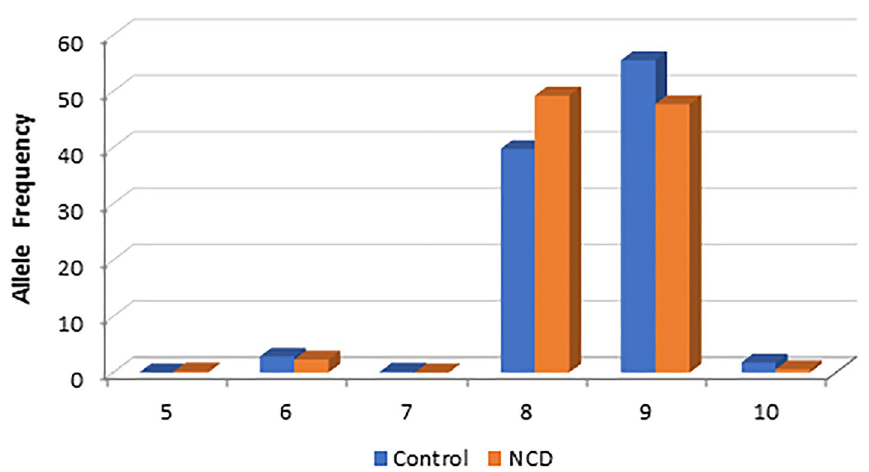
Figure 1. Allele frequency of the SBF1 (GCC)-repeat in the human samples studied. While multiple alleles were detected, the 8 and 9-repeat alleles were predominantly abundant. Significant excess of the 8-repeat was detected in the NCD group versus